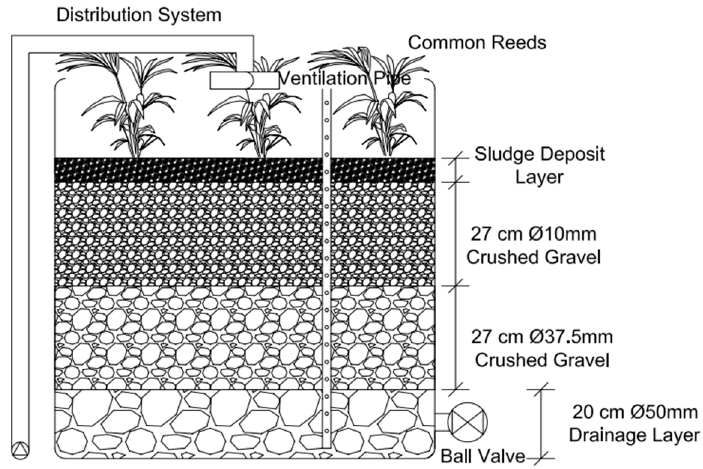
Figure 1. Cross section of Phase II wetlands.